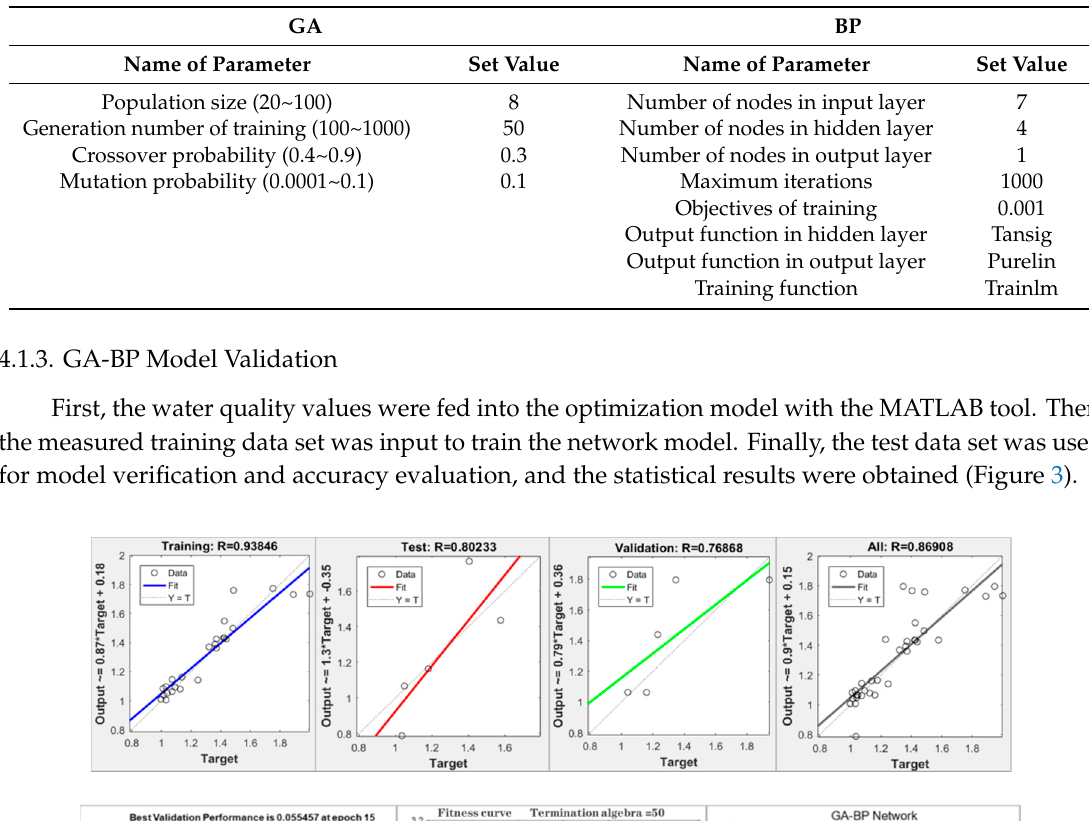
Table 2. The basic parameters of the model Settings.